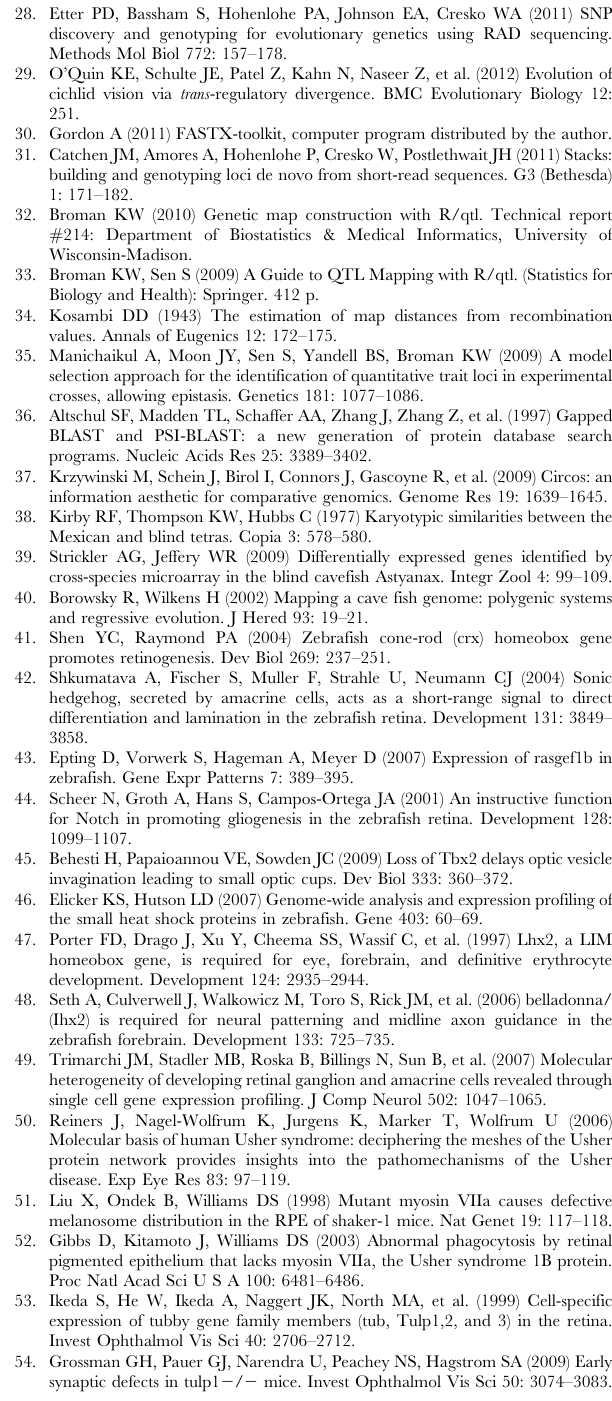
Table S2 Linkage and comparative mapping position of all genetic markers used in this study, including their LOD of association with retinal thickness. Table S3 Retinal measurements and marker genotypes used to scan the Astyanax genome for QTL related to retinal degeneration.